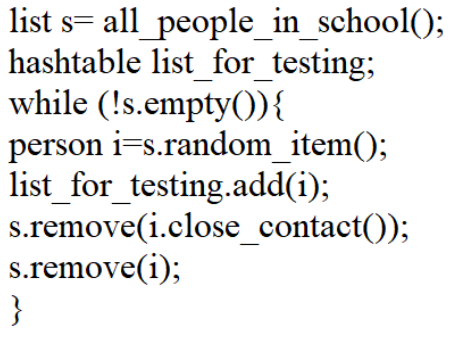
Figure 5. The pseudo code to identify infected people quickly.